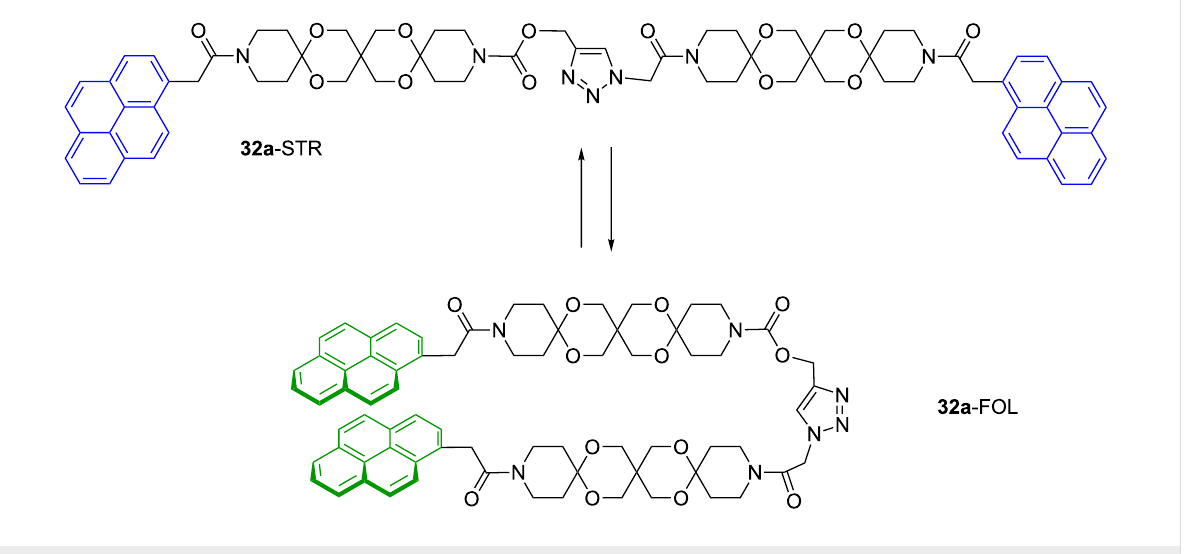
Scheme 11: Stretched-folded equilibrium of pyrene labelled AR 32a .